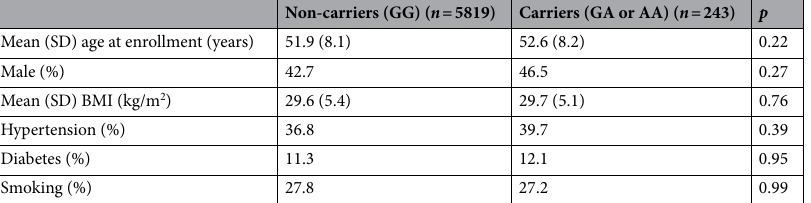
Table 1. Baseline characteristics of the African ancestry UK Biobank study population ( n = 6062) by V122I genotype.